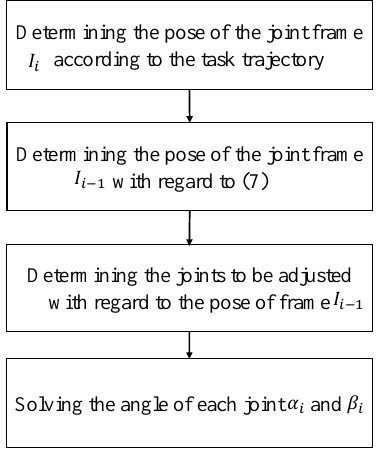
Figure 4. Inverse kinematics of